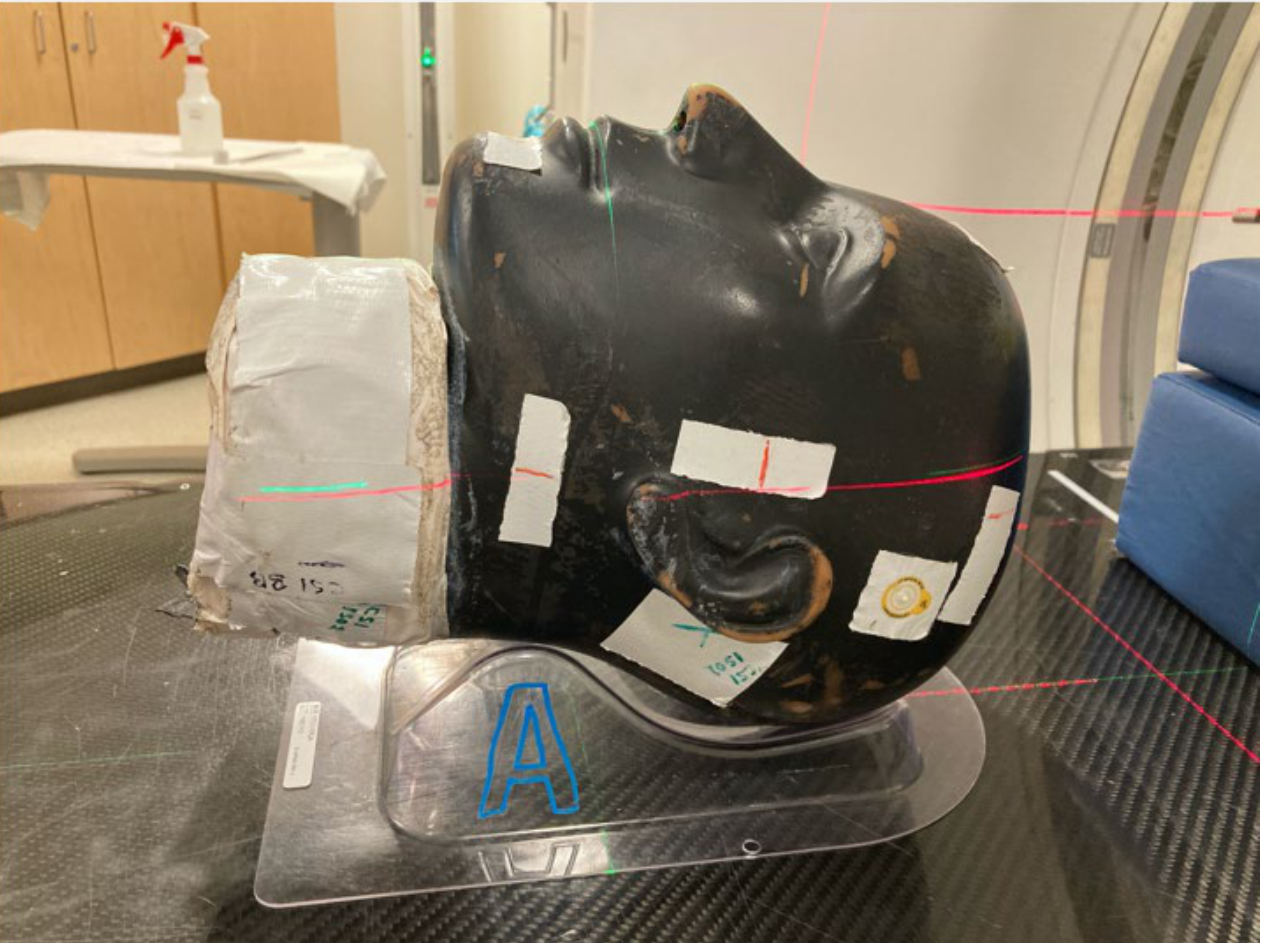
Figure 1. Head phantom used to establish low-dose scanning protocols. Table 1. Scanning parameters used for phantom measurements. The standard protocol (STD) is highlighted in bold.